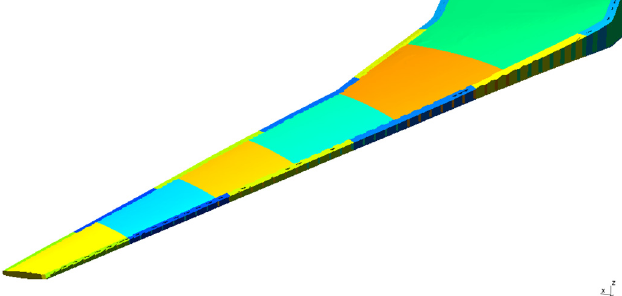
Fig. 1. Different thickness regions for modal optimization (12 in total). For each section, the thickness of the panels on the lower surface of the wing is the same as on the upper side.